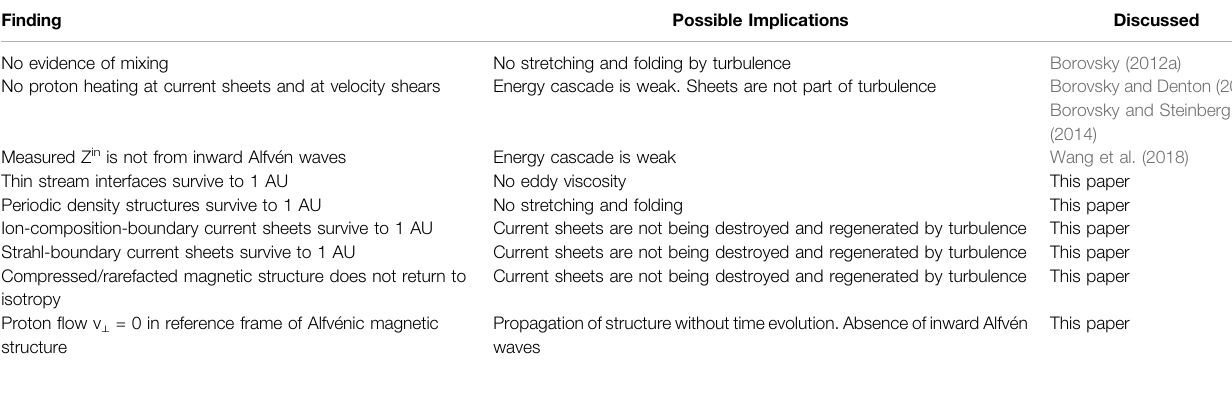
TABLE 1 | Implications for solar-wind turbulence raised by the fi ndings of the non-destruction of solar-wind structures.